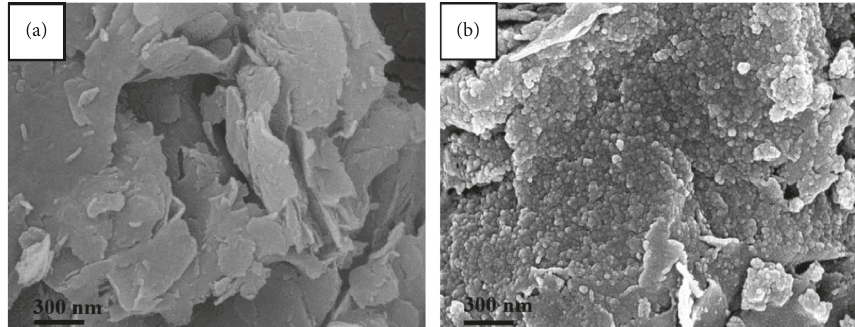
Figure 1: SEM images of the synthesized Bent-Fe and Fe-TiO